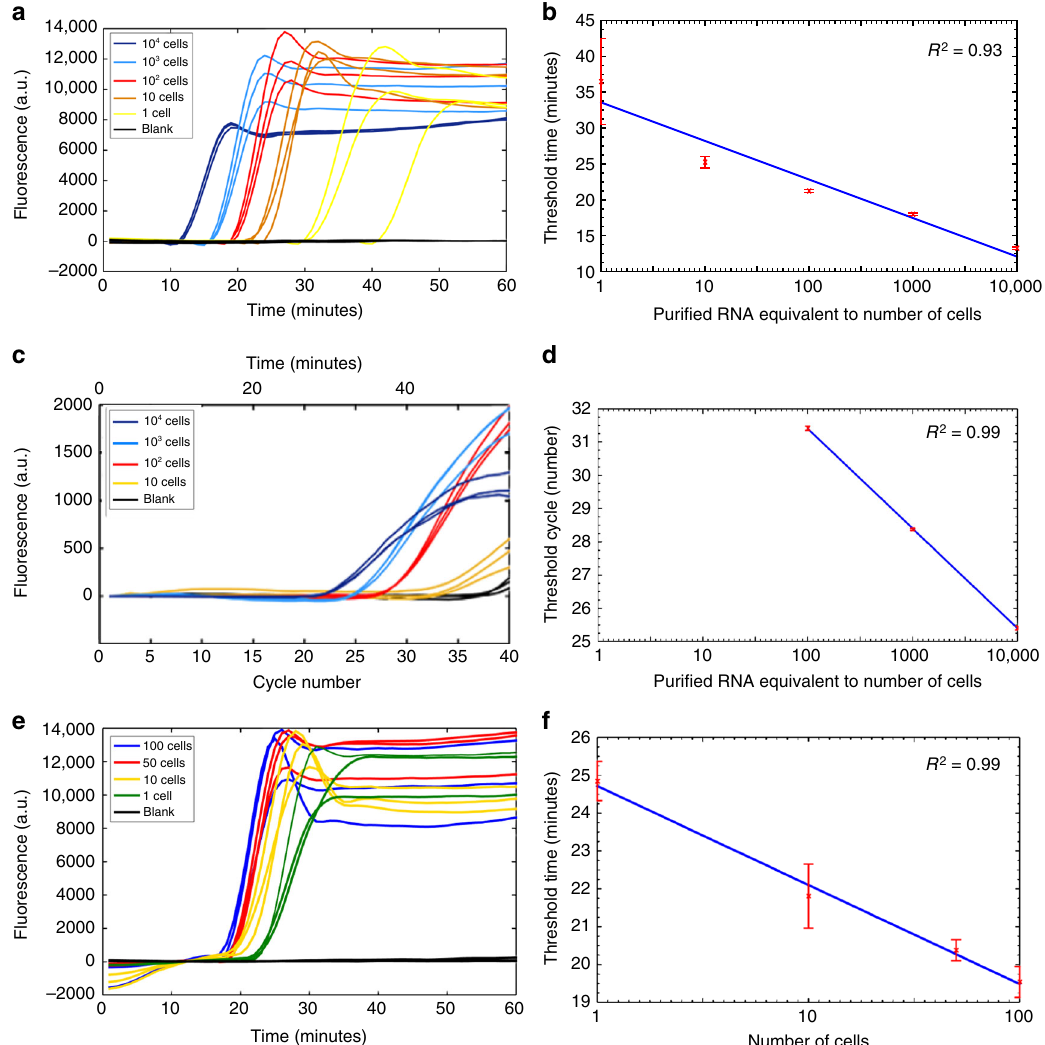
Fig. 2 Off-chip RT-LAMP assay characterization. a , b Ampli fi cation curves and standard curve of the TOP2A mRNA RT-LAMP with puri fi ed total RNA extracted from LNCaP cells. 10 4 cells had 940 ng of puri fi ed total RNA per reaction as measured with nanodrop spectrophotometer. c , d Ampli fi cation curves and standard curve of the RT-PCR assay for TOP2A mRNA performed using previously published primers 20 . Our RT-LAMP assay can detect TOP2A mRNA from a single cell in a reaction tube, whereas the RT-PCR assay can detect mRNA from only up to 100 cells (~9.4 ng total RNA) in a reaction tube (25 µ L per reaction). The amounts of RNA per reaction for each dilution was the same as in RT-LAMP ( a ) to allow direct comparison. e , f Ampli fi cation curves and standard curve of the TOP2A mRNA RT-LAMP assay with whole cells spiked directly into the reaction tubes. TOP2A mRNA down to a single cell could be reliably ampli fi ed. All the reactions had three replicates ( n = 3) and the error bars show the standard deviation